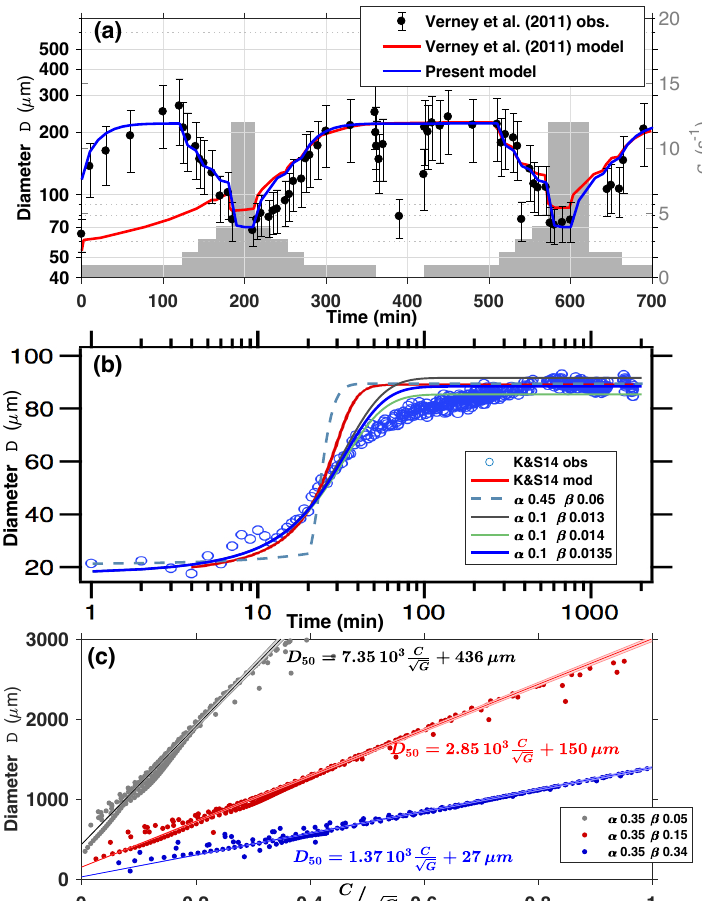
Figure 3. Comparison of ROMS implementation of FLOCMOD with laboratory and theoretical results. (a) Laboratory response of floc size to simulated fluctuations in shear rate G (gray shading) showing observed area-weighted mean floc diameter D (black dots with + /1 stan- dard deviation bars), model results presented in Verney et al. (2011; red line), and ROMS FLOCMOD simulation (blue line). (b) Laboratory response of floc size to rapid increase in shear rate from G = 0 to G = 15s − 1 showing sizes measured by Keyvani and Strom (2014; K&S14; blue circles), K&S14 model results (red line), and ROMS FLOCMOD results for various combinations of aggregation and breakup parame- ters (dashed and colored lines). (c) Equilibrium diameters produced by steady ROMS FLOCMOD simulations with a range of concentrations, shear rates, and aggregation and breakup parameters (dots). These fall along lines with slopes determined by the ratio of aggregation and breakup parameters, according to theory (Winterwerp,